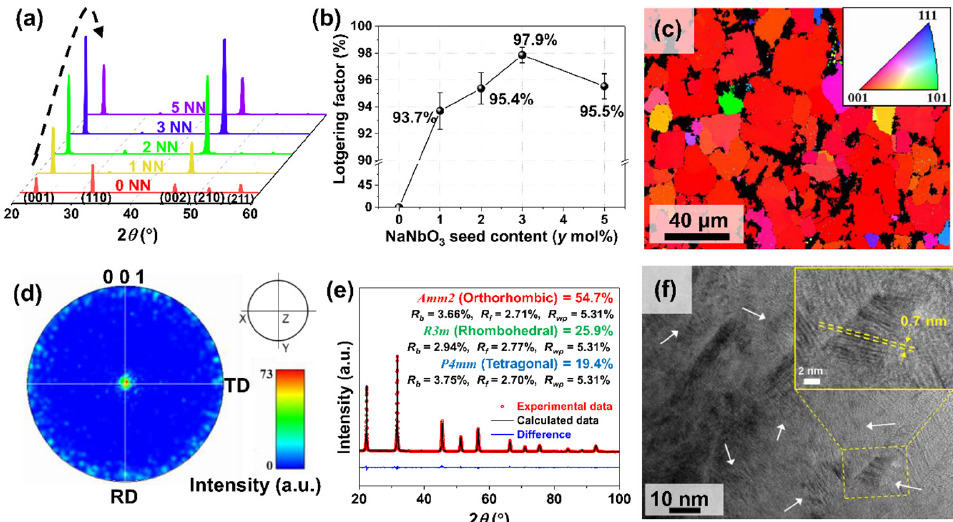
Figure 1. ( a ) XRD patterns and ( b ) Lotgering factors of the NKNS-0.02SZ-0.02BAZ + y mol% NN thick films (0.0 ≤ y ≤ 5.0) sintered at 1090 ◦ C for 3 h. ( c ) EBSD image, ( d ) (001) pole figure of the top surface, ( e ) Rietveld refinement of the XRD pattern, and ( f ) HRTEM image of the NKNS-0.02SZ-0.02BAZ + y mol% NN thick film with y = 3.0. Table 1. Parameters calculated from the Rietveld refinement of the XRD data of the NKNS ‐ 0.02SZ ‐